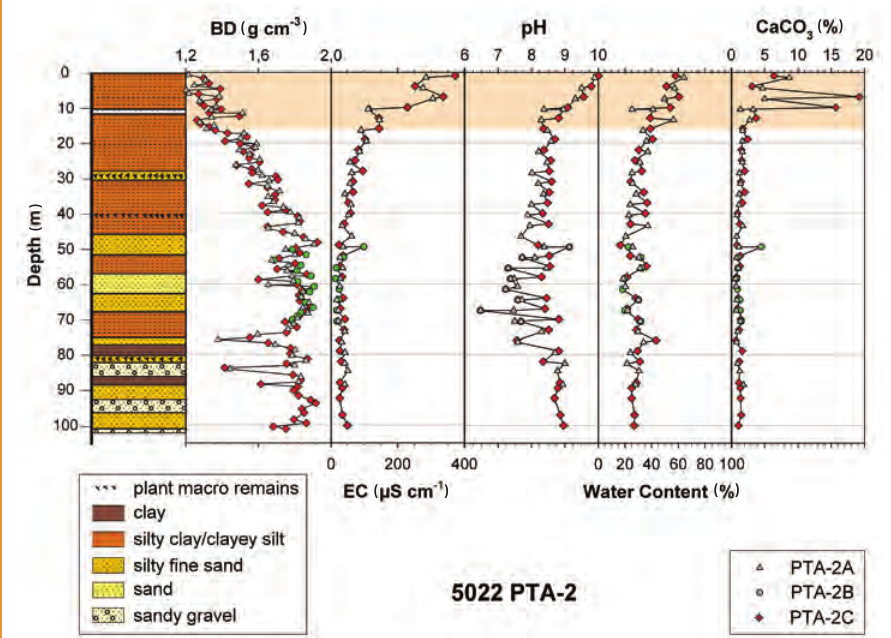
Figure 5. Lithostratigraphy and records of bulk density (BD), electrical conductivity (EC), pH, water content, and carbonate content (CaCO 3 ) based on core catcher samples from site PTA-2 (combined holes A, B, and C) as obtained in the field laboratory. The Holocene section of the record is shaded in an orange hue (top).